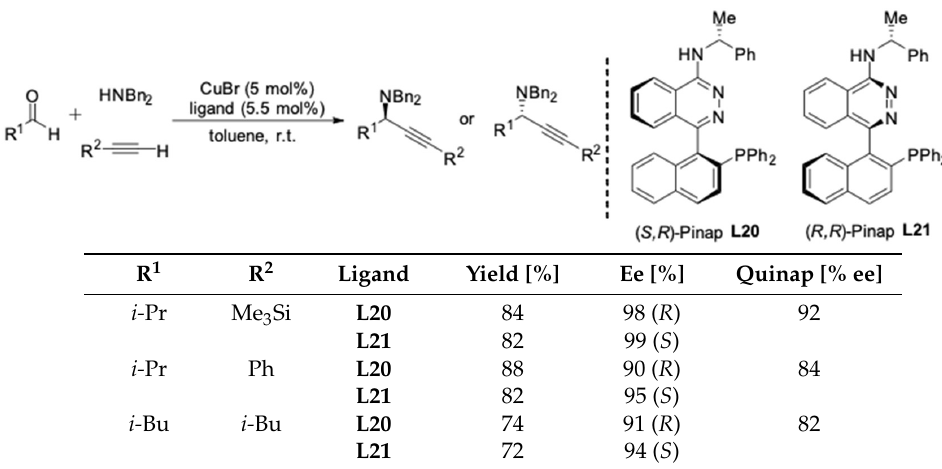
Table 3. CuBr/Pinap-catalyzed AA 3 -coupling.